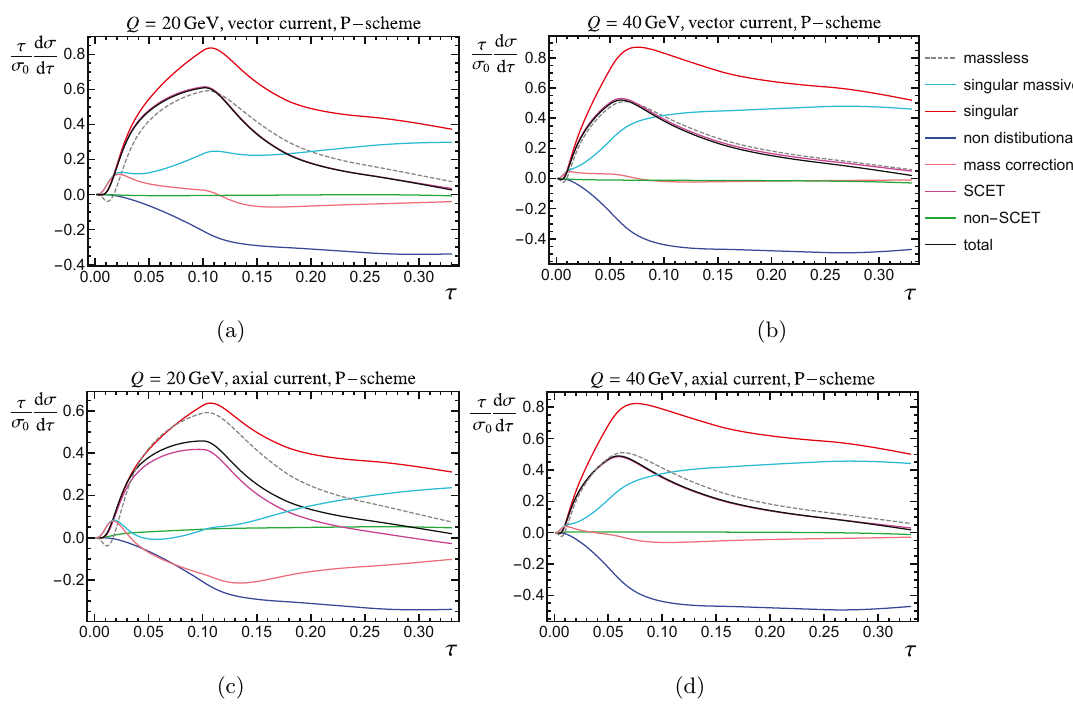
Figure 7 . Decomposition of the di(cid:11)erential cross section at Q = 20 GeV (left panels) and 40 GeV (right panels) in various components for the vector (upper plots) and axial-vector (lower plots) currents. Red and blue correspond to the singular and non-distributional terms, respectively, while their sum de(cid:12)nes the SCET cross section, shown in magenta. The massless approximation is shown as a dashed gray line, while massive singular corrections are depicted in cyan. The massive corrections to the SCET cross section (massive singular plus non-distributional) are shown in pink. Finally, the black solid line is the sum of all